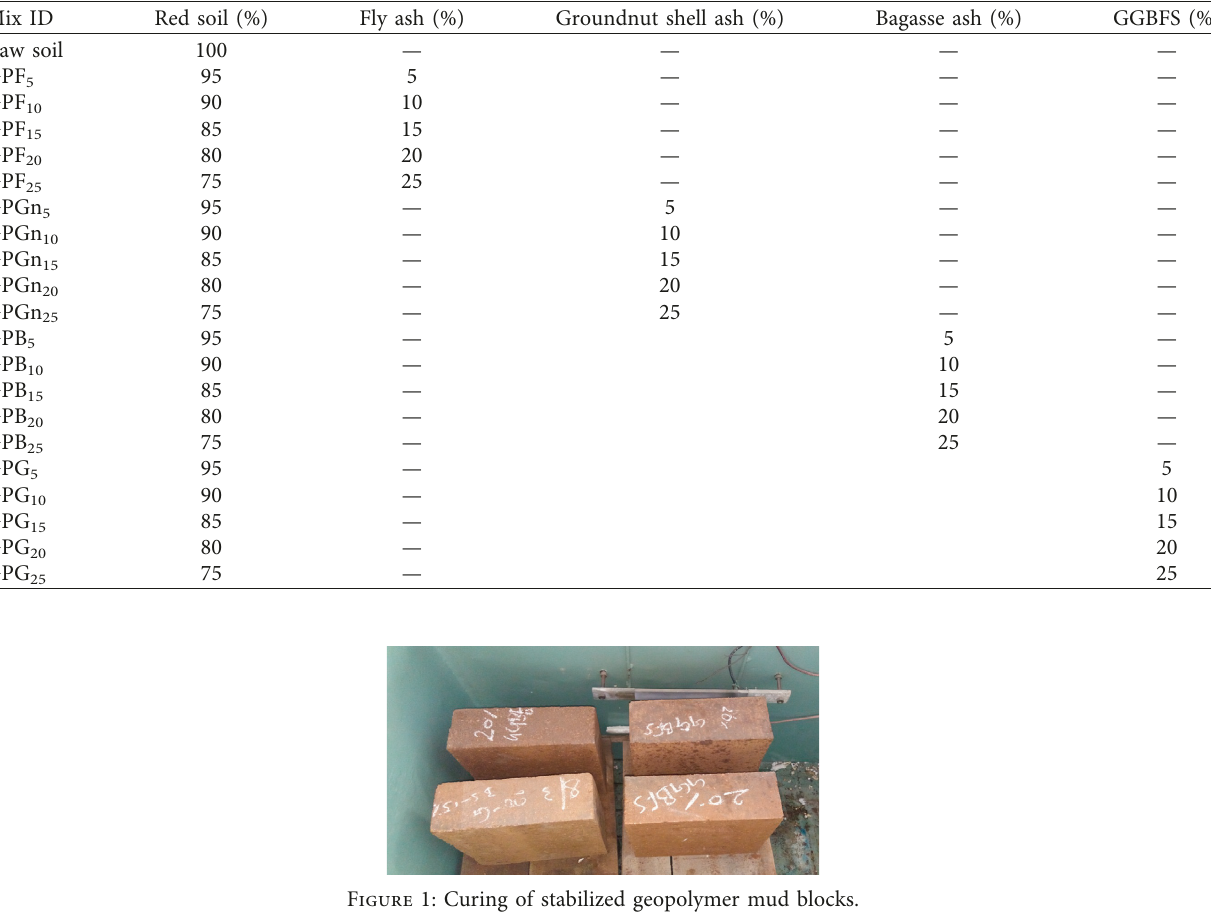
Table 1: Mix proportion of stabilized geopolymer mud blocks.